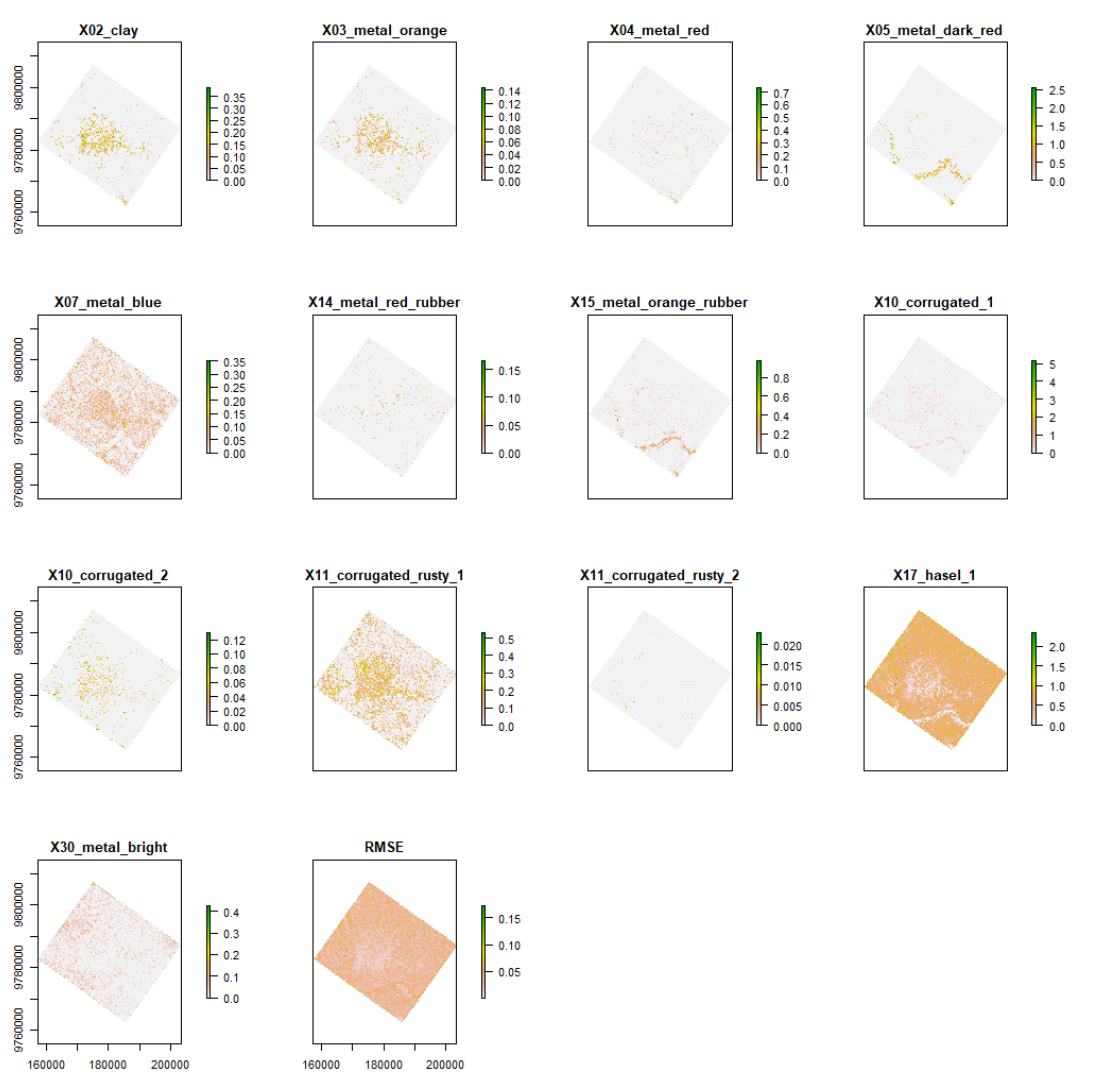
Figure 7: mesma plots for all the materials and RMSE; Values in the mesma function vary between